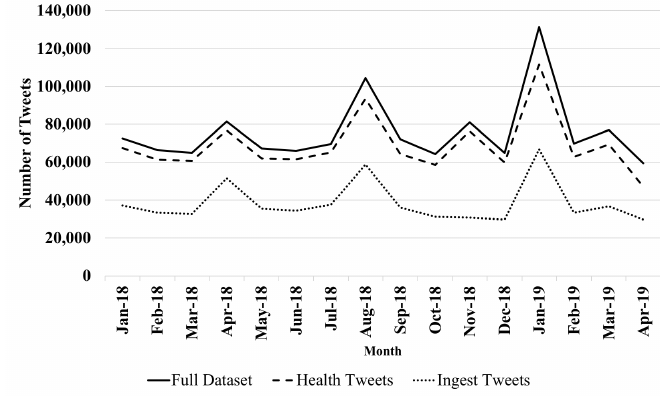
Figure 1. Monthly Volume of Tweets. Table 2. Number of Tweets by